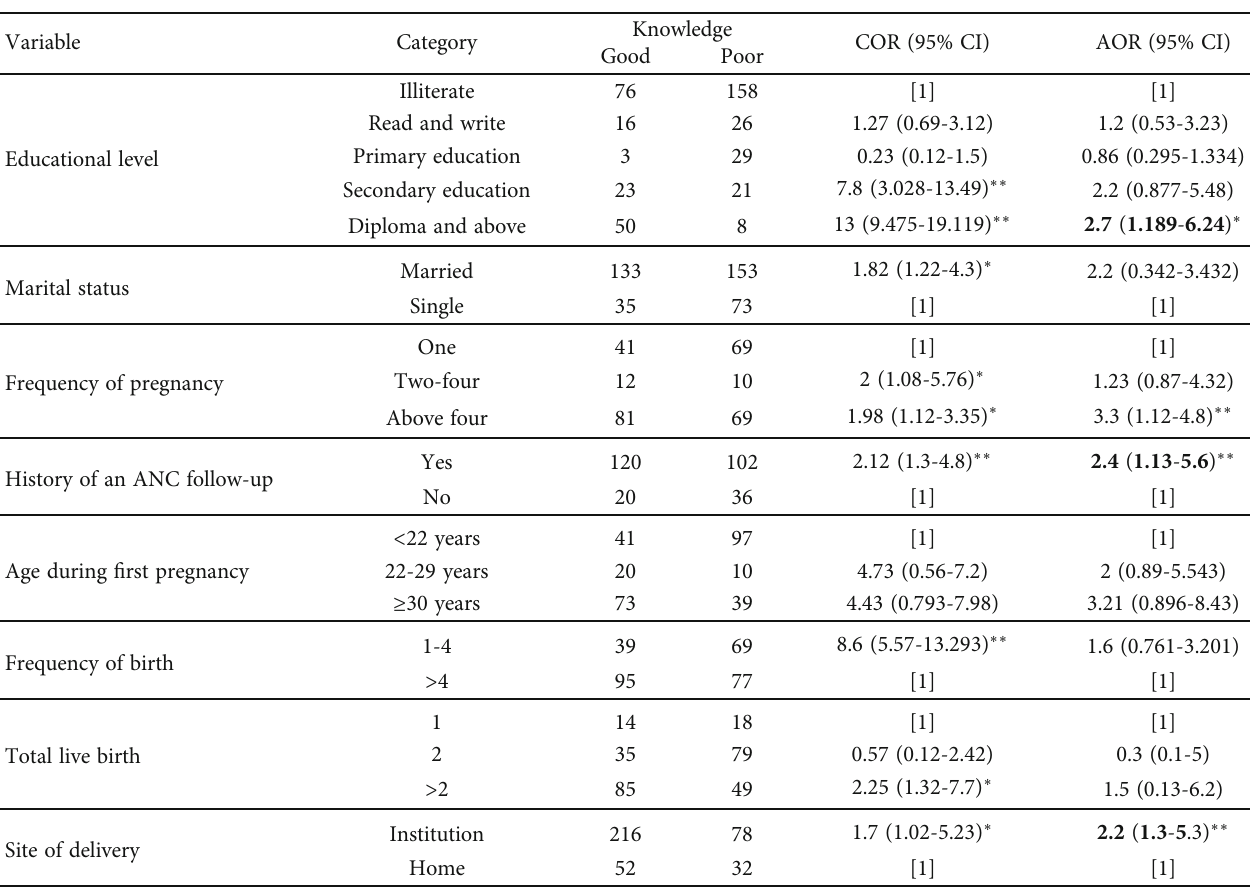
Table 4: Associated factors of knowledge on obstetric danger sign among reproductive-age women in southeastern zone of Tigray, Ethiopia,